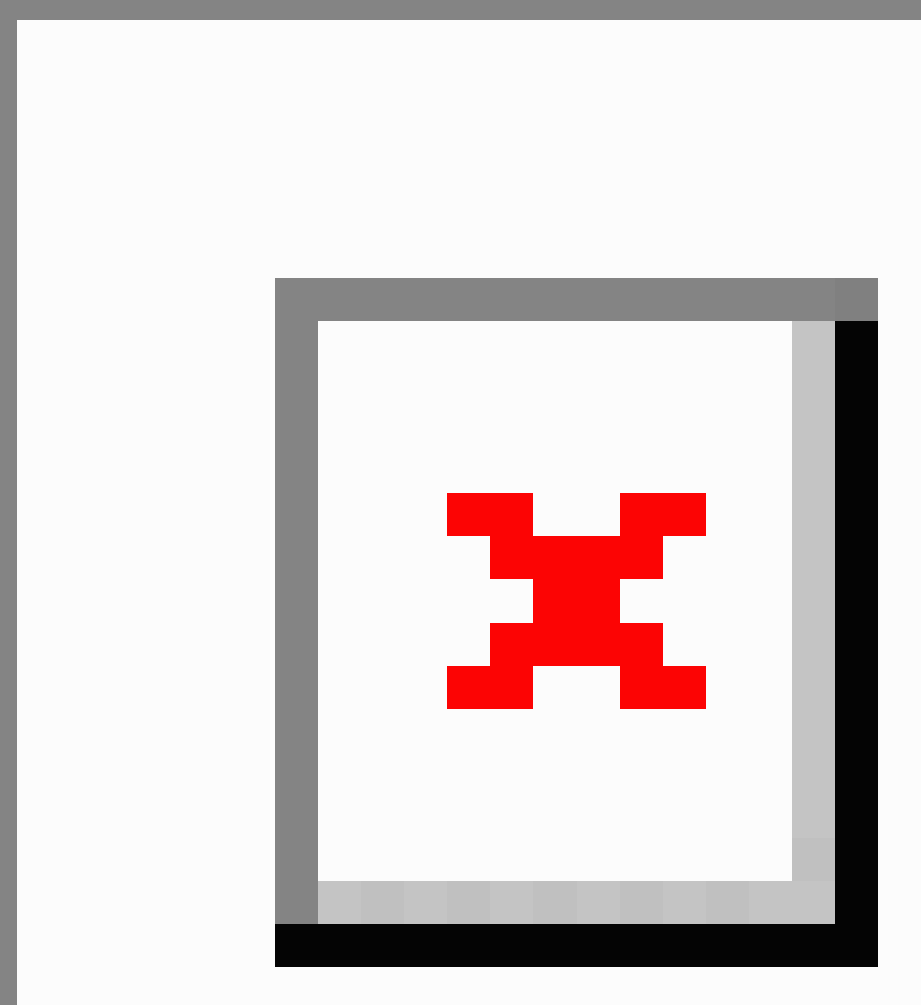
Figure 1. The system architecture of the Web-based newborn screening